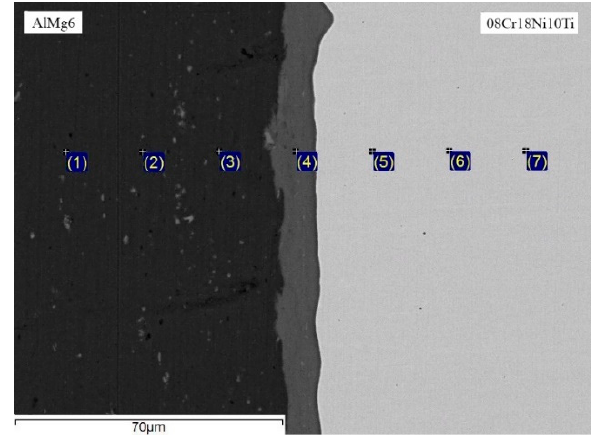
Figure 11. SEM image for AlMg6–08Cr18Ni10Ti weld interface. Table 3. EDS results for AlMg6-08Cr18Ni10Ti interface (all results in wt %).